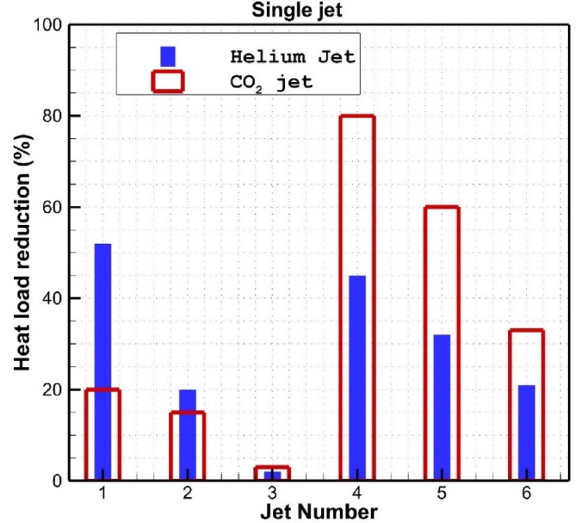
Figure 9. Comparison of the heat load reduction of single coolant jet on the main body for different jet